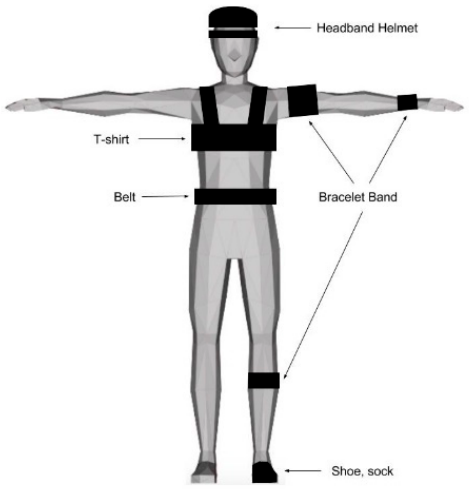
Figure 3. Main locations of biomedical sensors for ambulatory uses [49].